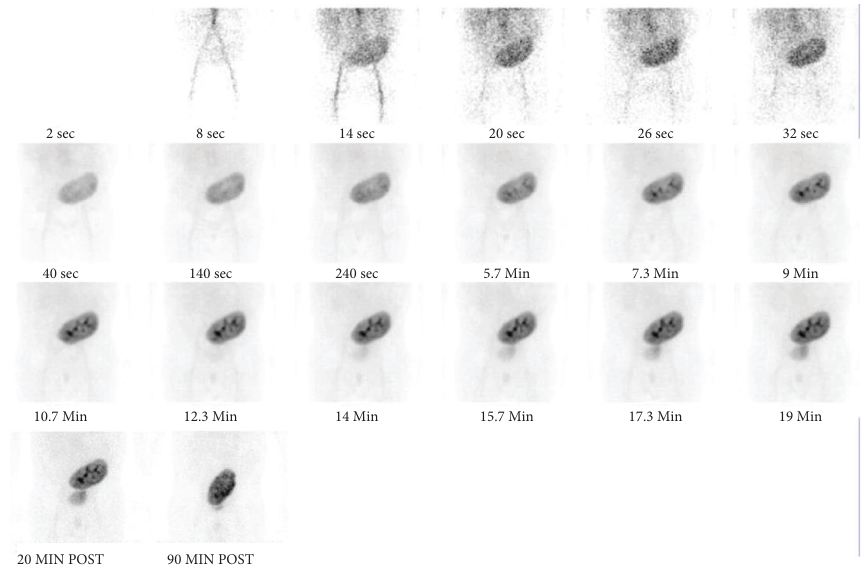
Figure 3: Kidney scintigraphy performed on day 115 post-transplantation demonstrating a return of perfusion to the kidney